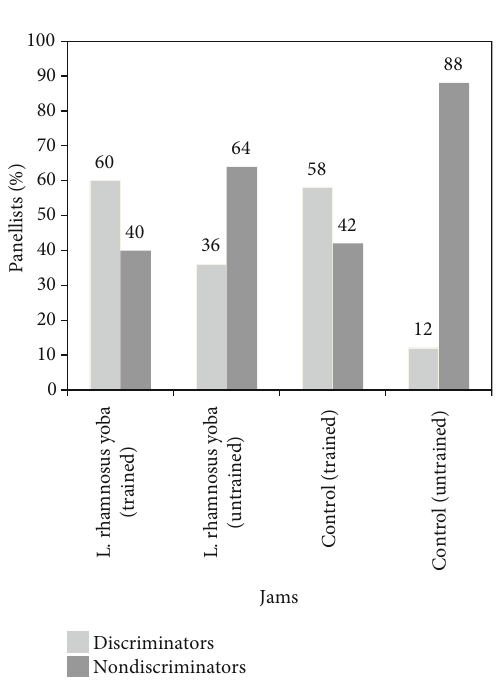
Figure 6: Triangle test (discrimination between L. rhamnosus yoba and control jams).